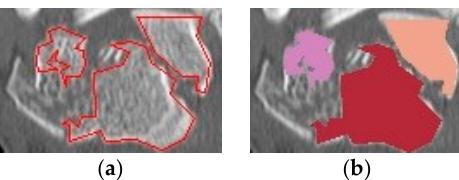
Figure 11. Fragment segmentation: ( a ) Contour detection and ( b ) Color segmentation.